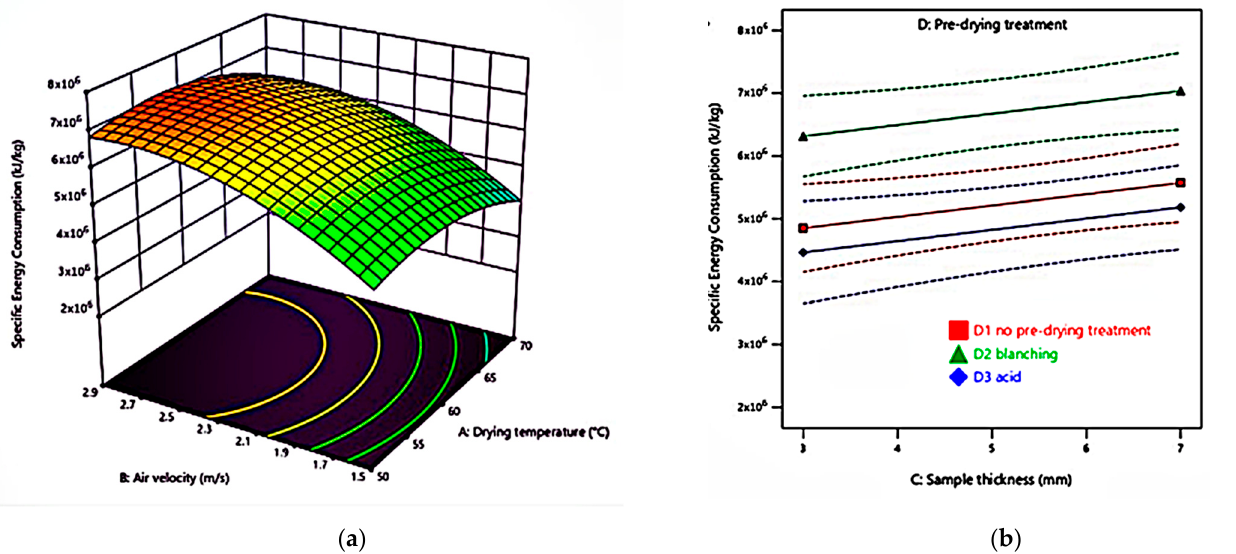
Figure 7. ( a ) Specific energy consumption of 5 mm sample thickness, blanching pre-drying treatment celeriac slices hot air at different drying temperatures and air velocities; ( b ) specific energy consumption of different sample thicknesses and pre-drying treatments of celeriac slices hot air at 60 °C of drying temperature and 2.2 m/s of air velocity.